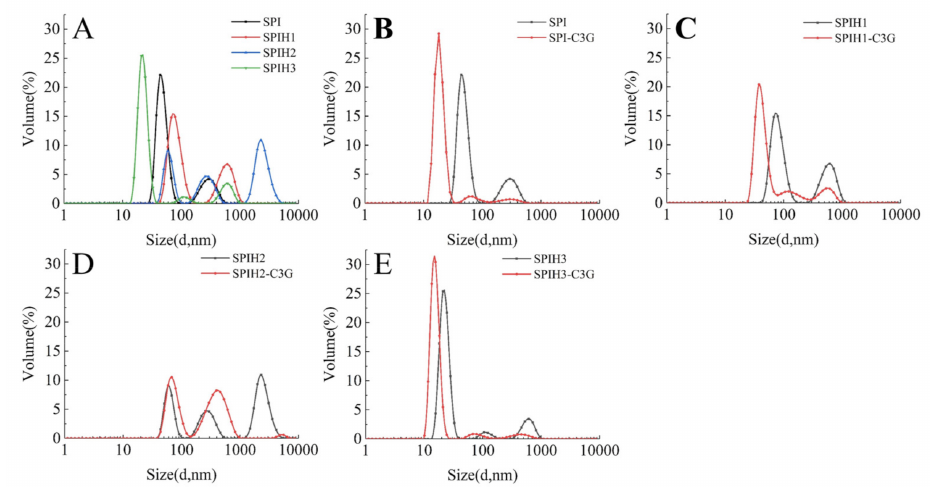
Figure 5. Particle size distributions of SPI and SPIHs with the absence ( A ) and presence ( B – E ) of C3G. The mass concentration ratio of SPI/SPIHs and C3G was